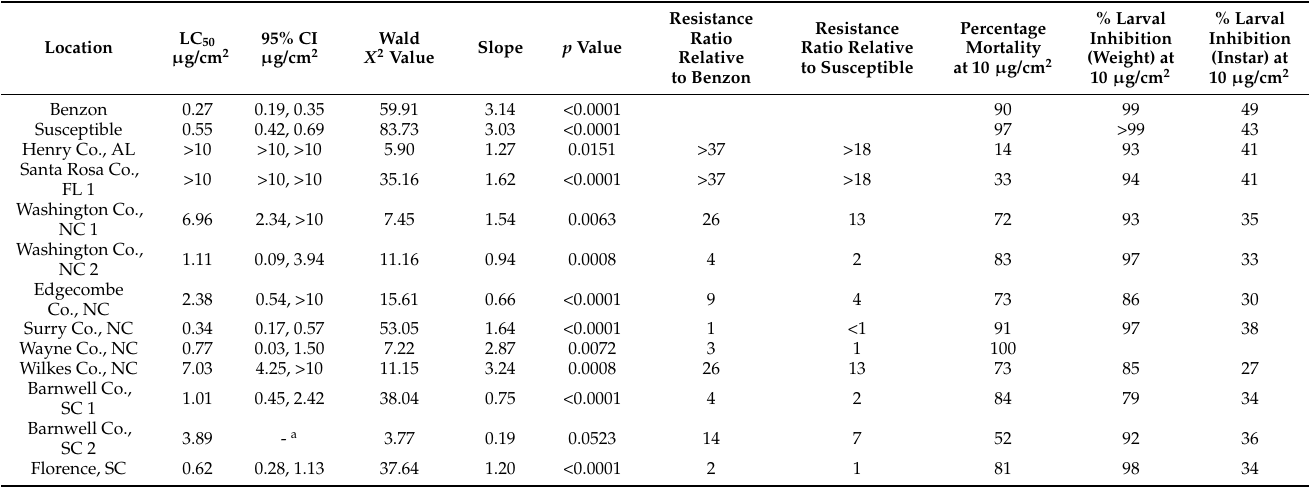
Table 2. Bioassay results for Cry1Ac, 2019. 1 and 2 refer to different collections from the same county, but different locations within the county.